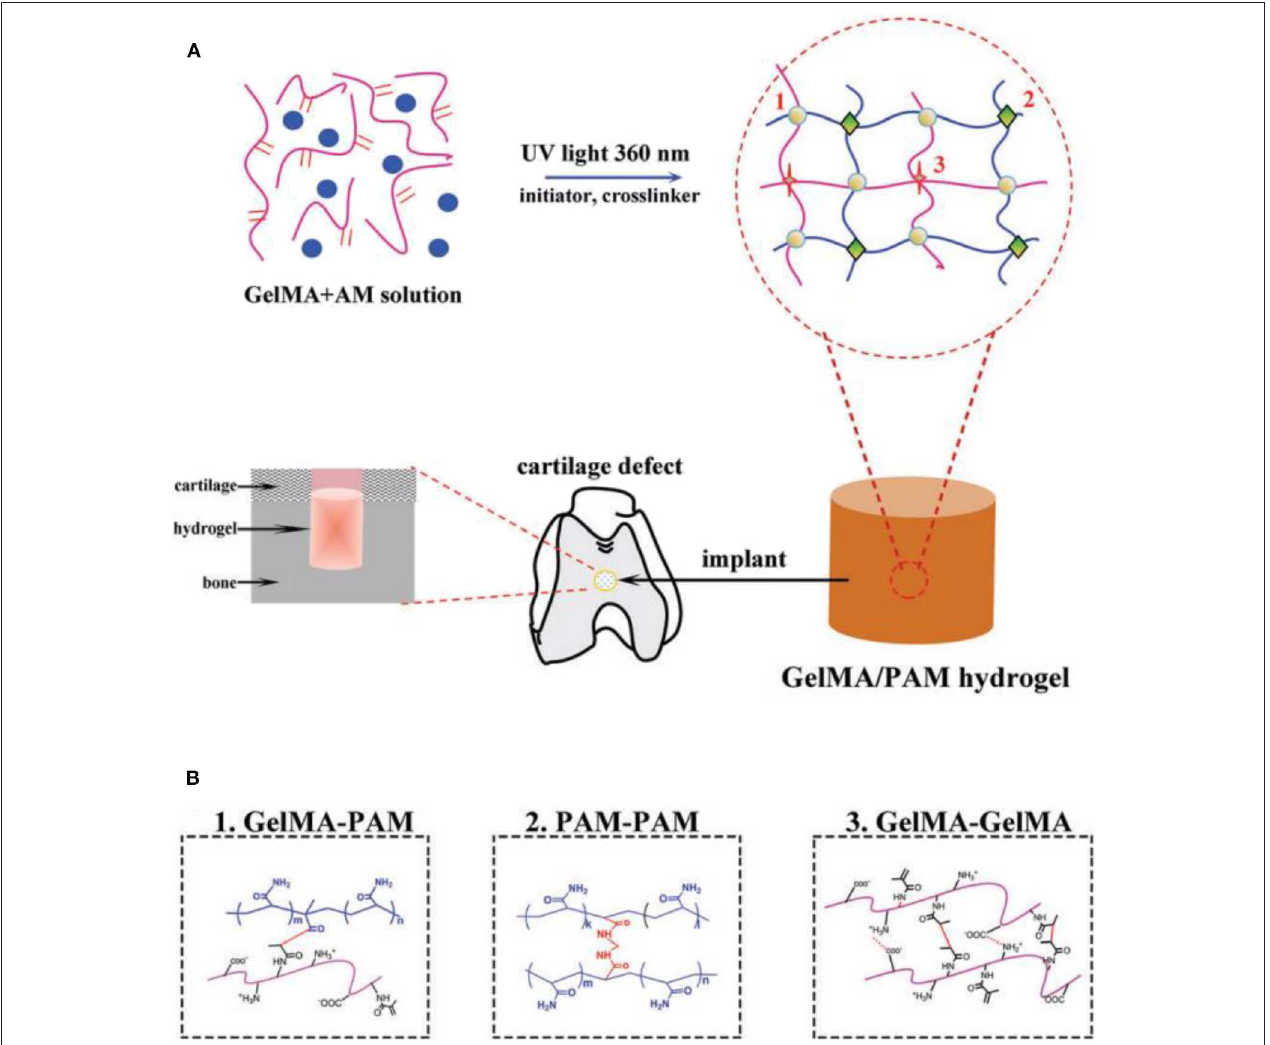
FIGURE 4 | (A) Schematic illustration for fabricating natural-synthetic GelMA-PAM biohybrid hydrogel via the photo-initiating polymerization. (B) Molecular crosslinking structures: covalent crosslinking between GelMA-PAM, covalent crosslinking between PAM-PAM, and covalent/physical crosslinking between GelMA-GelMA. Reproduced from Han et al. (2017) with permission from Copyright 2017 Royal Society of